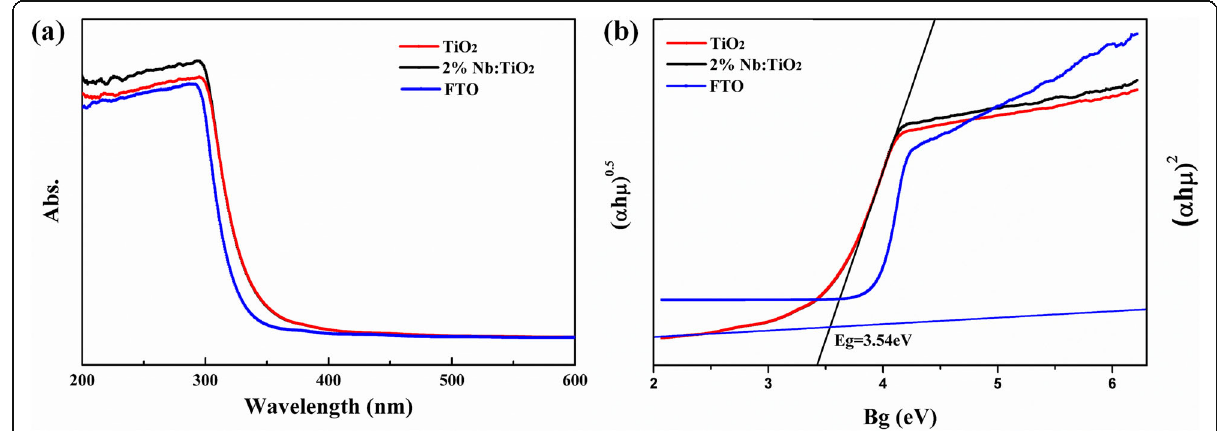
Fig. 4 a The absorption spectra of the FTO substrate, TiO 2 /FTO, and 2% Nb:TiO 2 /FTO. b Tauc-plots of the FTO substrate, TiO 2 /FTO, and 2% Nb:TiO 2